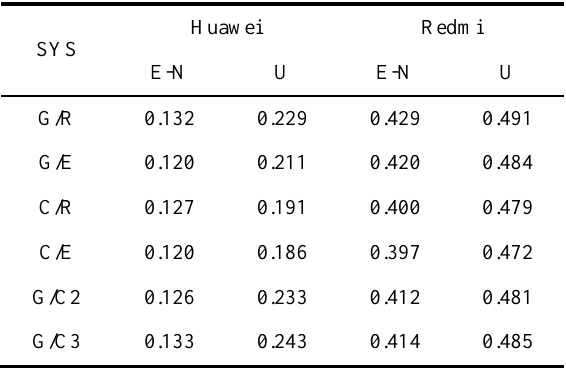
Figure 16. The average PDOP for dual/triple-constellation in velocity determination. Table 5. RMS of dual/triple/quad-constellation velocity determination error. (Unit: